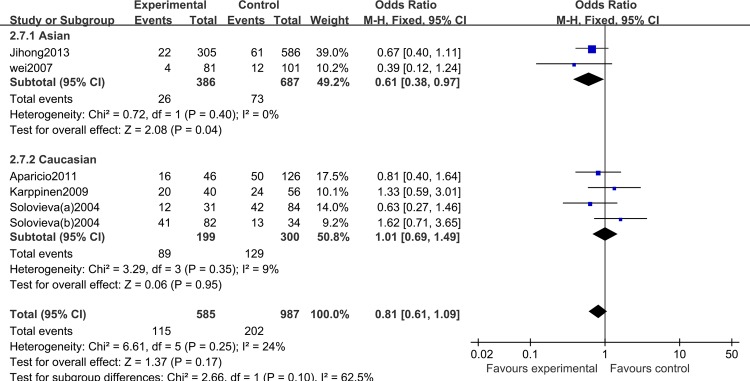
Forest plot of allelic comparison of IL-1β (+3954C/T) polymorphism for overall comparison (CT versus CC).